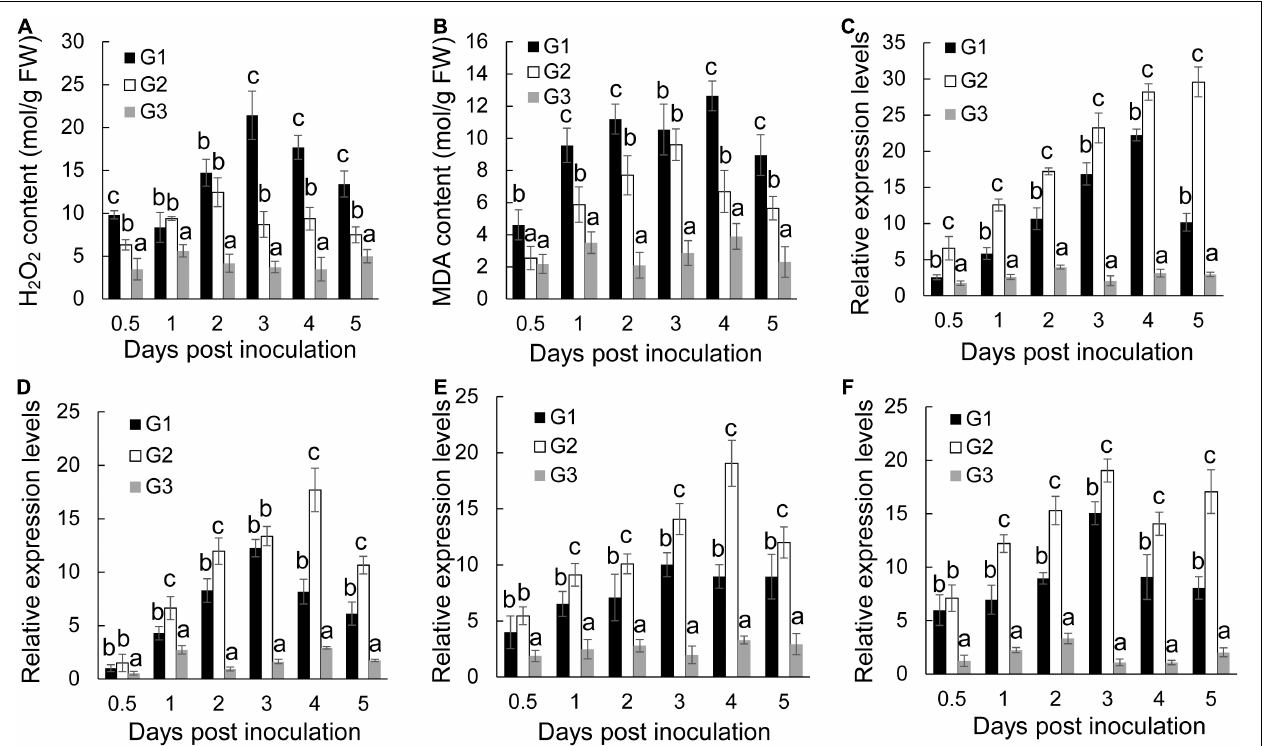
FIGURE 4 | Effects of S. malaysiensis 8ZJF-21 on the activation of antioxidant system. G1: Foc TR4-GFP treatment; G2: S. malaysiensis 8ZJF-21 + Foc TR4-GFP treatment; G3: medium treatment. (A) Measurement of H 2 O 2 content in the roots of banana seedlings after treatment at different time points. (B) Measurement of MDA content in the roots of banana seedlings after treatment at different time points. The expression levels of antioxidant enzyme genes were determined by qRT-PCR, including MaCAT (C) , MaSOD (D) , MaPOD (E) , and MaPPO (F) . Error bars indicate standard errors of the means from three repeated experiments. Different letters indicate a significant difference according to Duncan’s multiple range test ( P <